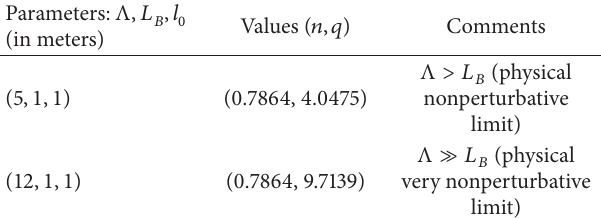
Table 2: PCF versus 𝑧